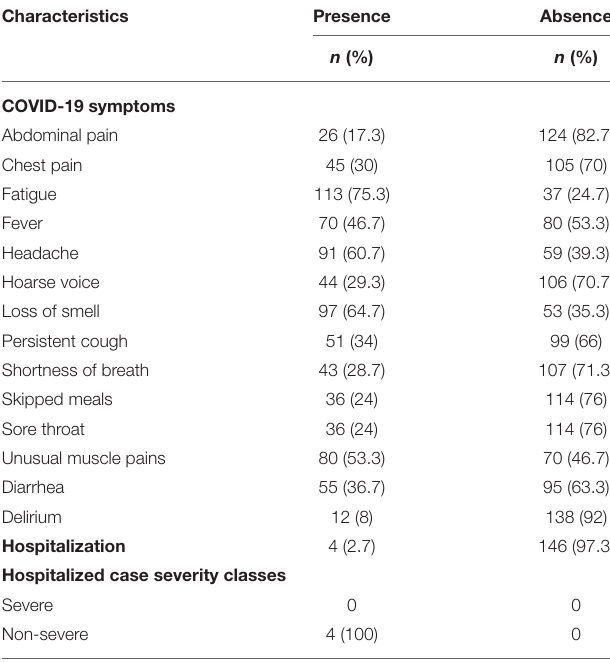
TABLE 7 | Multiple logistic regression for the association between the dietary intake and the occurrence of COVID-19.